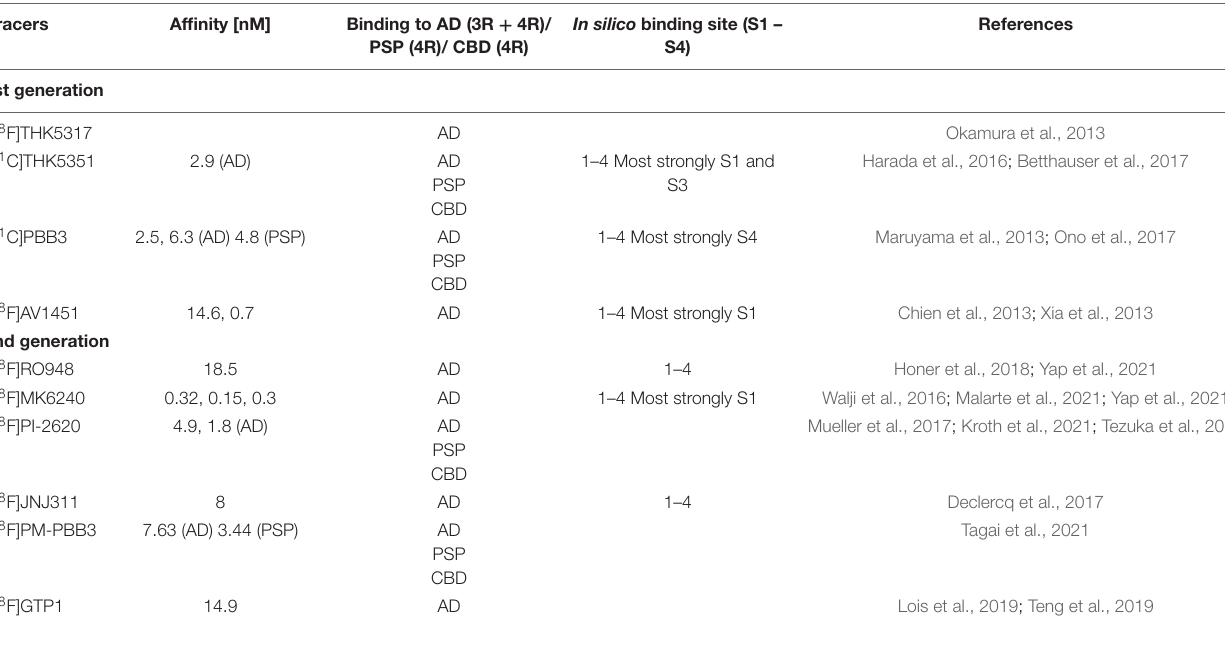
TABLE 1 | Binding properties of tau PET